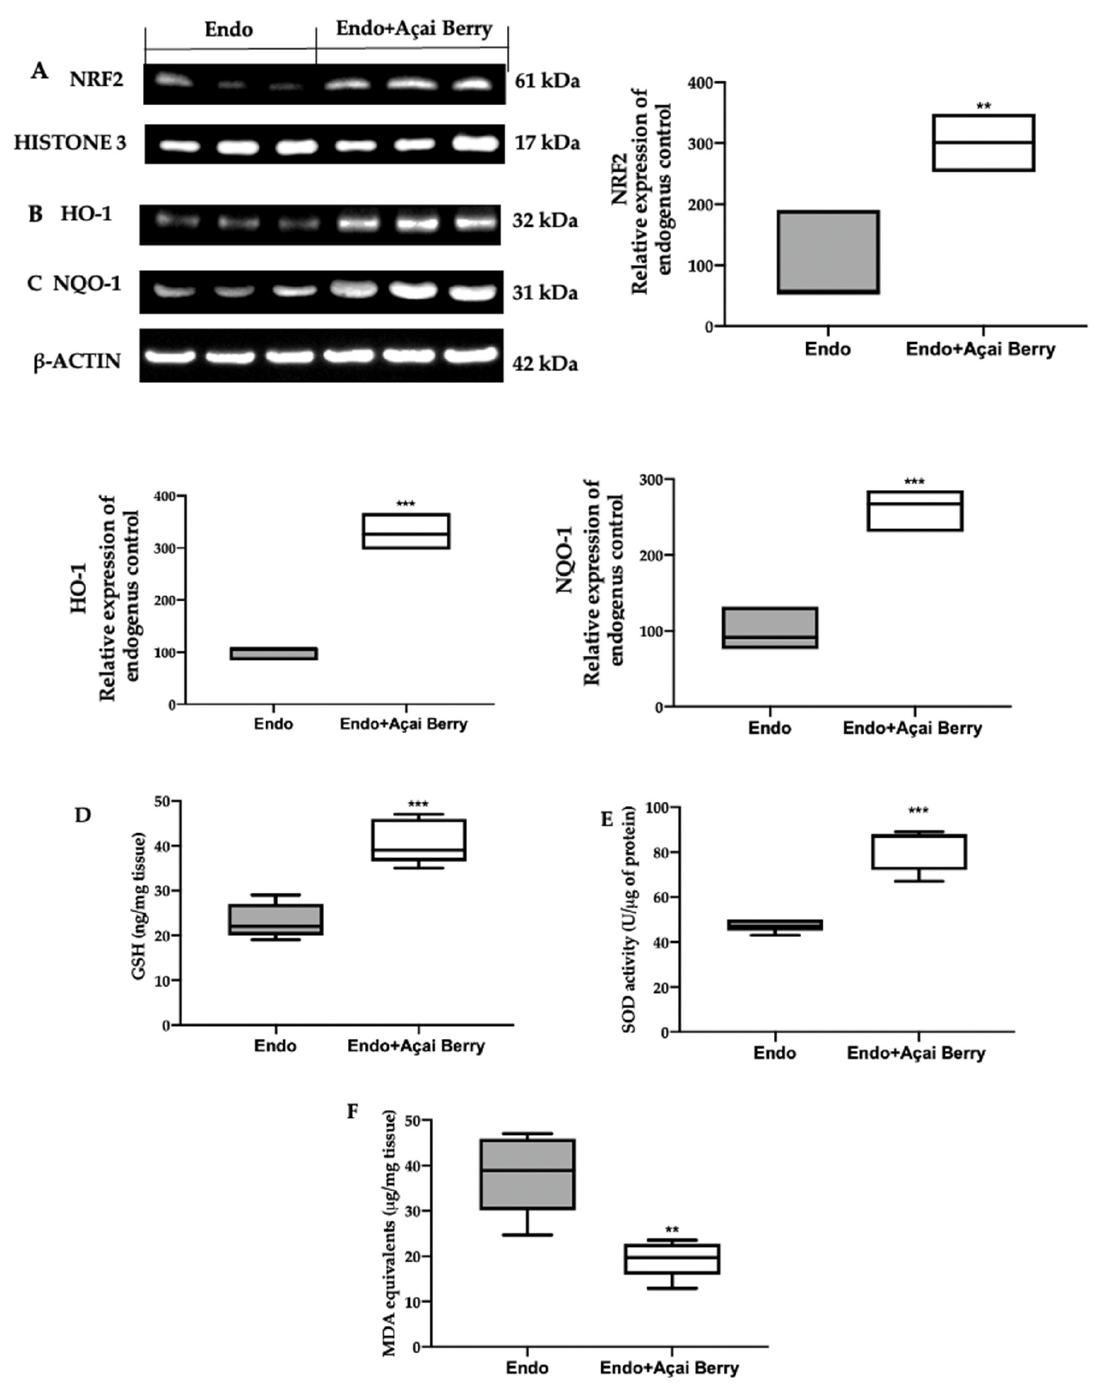
Figure 6. Analysis of Açai Berry administration on prooxidative alterations. Western blot analysis of NRF2 ( A ) nuclear expression, HO-1 ( B ) and NQO-1 ( C ) cytosolic expression, GSH levels ( D ), SOD activity ( E ) and MDA ( F ) levels. A p -value of less than 0.05 was considered significant. ** p < 0.01 vs. Endo, *** p < 0.001 vs. Endo.